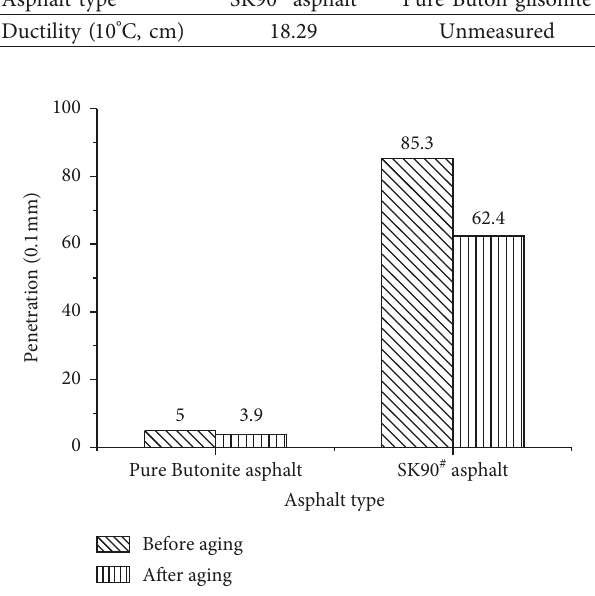
Figure 3: Comparison of antiaging properties between Buton rock pure asphalt and SK90 # asphalt.